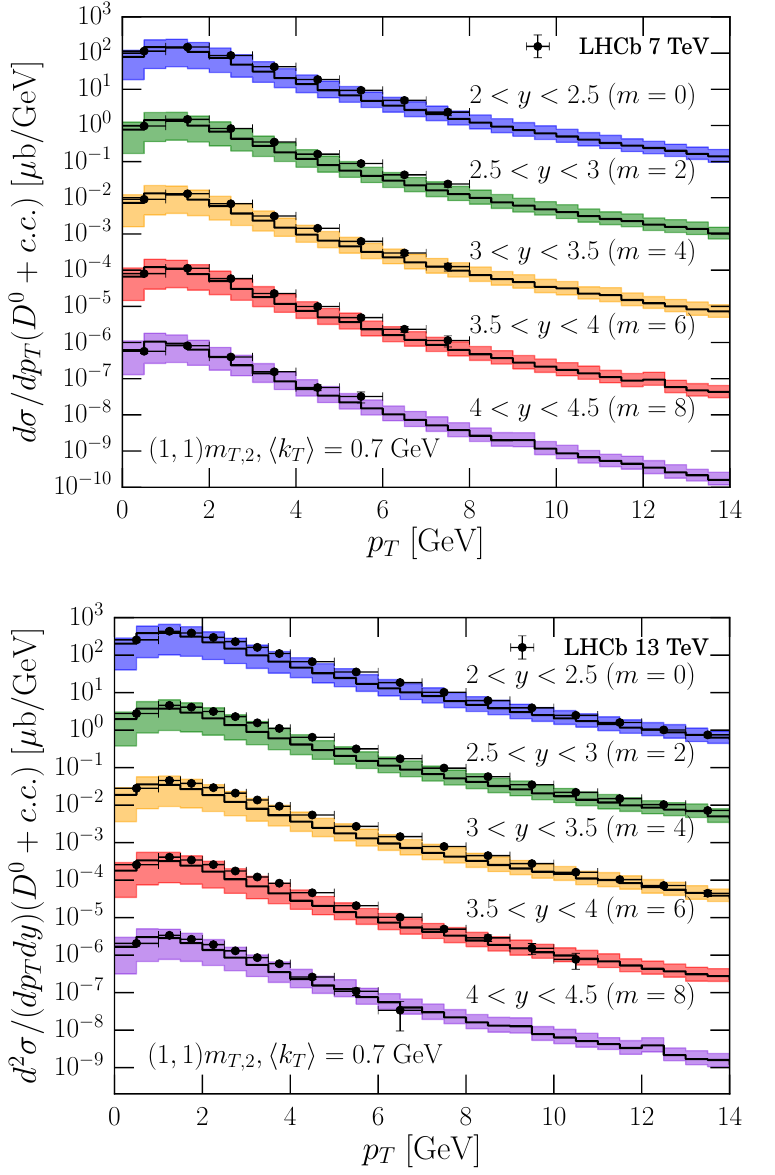
Figure 5. Same as in figure 4, but for production of D 0 and its charge conjugate, compared with √ LHCb data for s = 7 TeV [19] (upper) and 13 TeV [20]